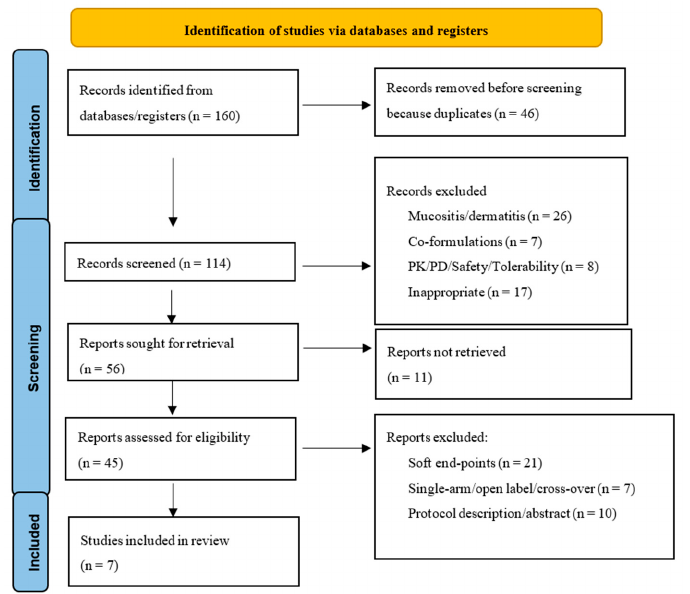
Figure 1. A fl owchart of the methodology used to select RCTs according to PRISMA. Figure 1. A flowchart of the methodology used to select RCTs according to